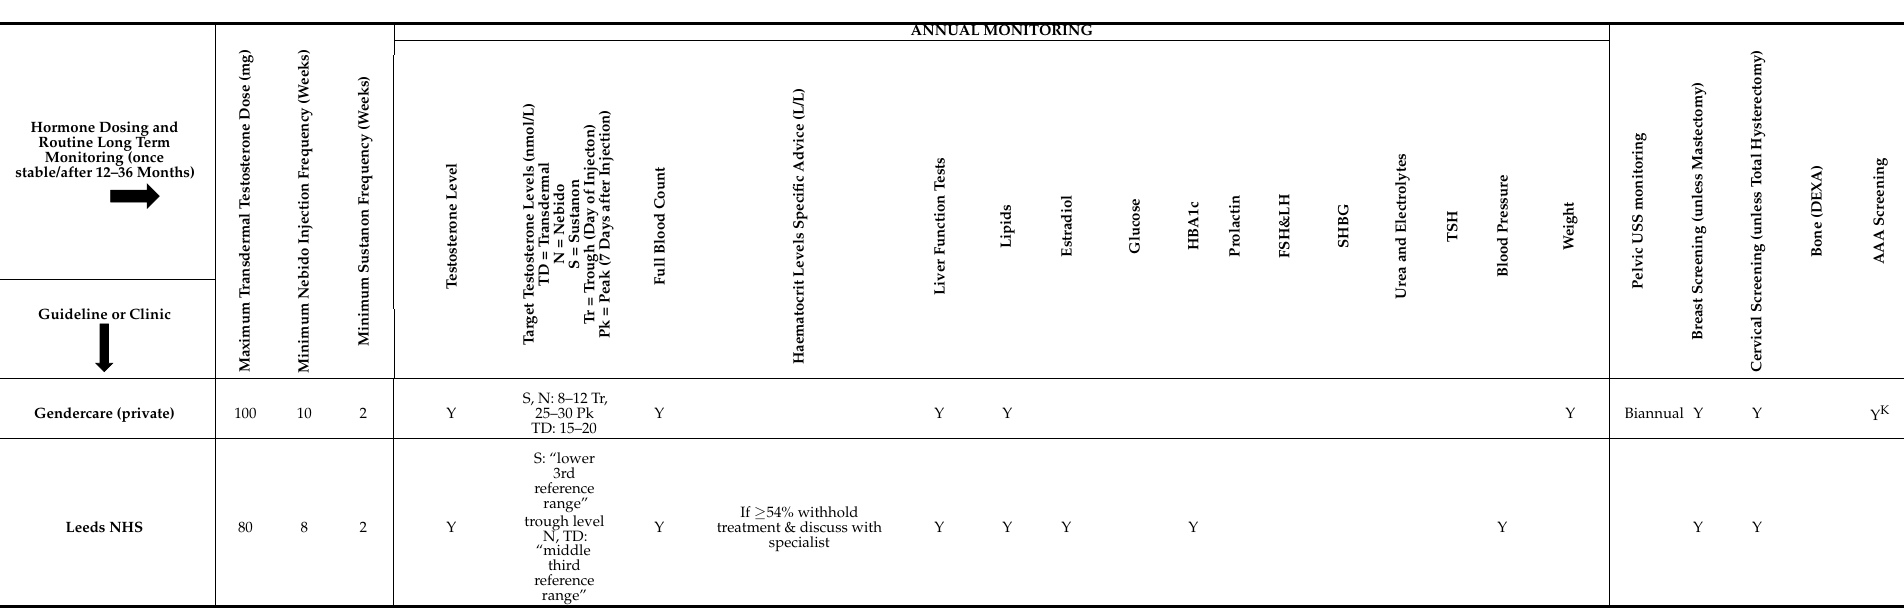
Table 2. Comparison of national, international, and patient specific prescribing and monitoring guidelines for trans women (observed males at birth) with gender dysphoria.